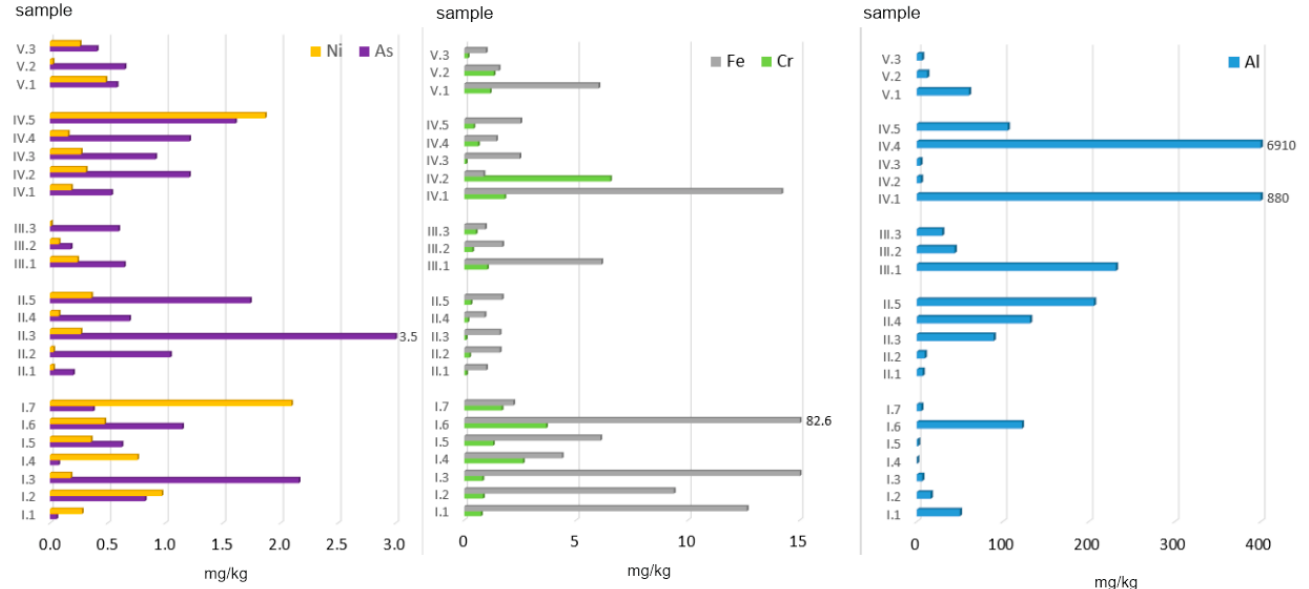
Figure 4. Bioaccessible fraction of PTEs in ashes burned in a household furnace.